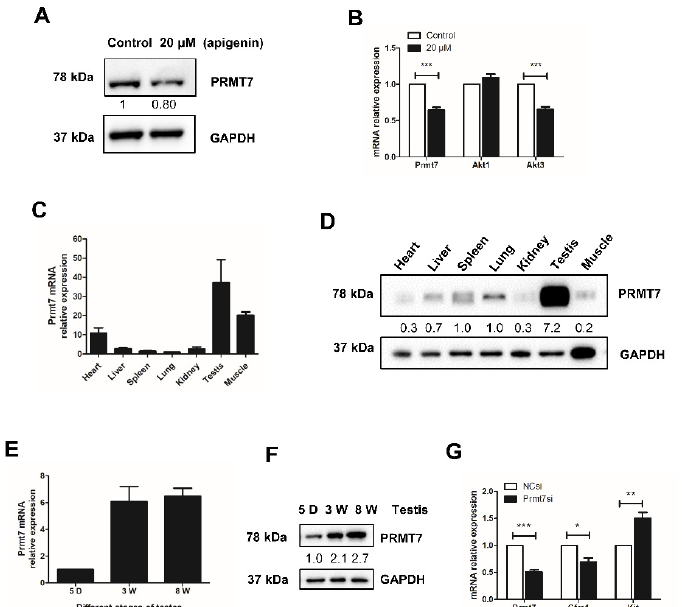
Figure 2. Effects of apigenin treatment on the expression of protein arginine methyltransferase 7 ( Prmt7 ) and Akt3 as well as Prmt7 expression profile in mouse tissues. ( A ) The protein level of PRMT7 was detected by Western blotting in spermatogonia treated with 0 and 20 µ M apigenin for 48 h. ( B ) Relative mRNA expression of Prmt7 , Akt1 , and Akt3 was examined by RT-qPCR in spermatogonia treated with 0 and 20 µ M apigenin for 48 h. ( C ) Relative mRNA expression of Prmt7 examined by RT-qPCR in the heart, liver, spleen, lung, kidney, testis, and muscle of 8-week old mice. ( D ) The protein level of PRMT7 was detected by Western blotting in the heart, liver, spleen, lung, kidney, testis, and muscle of 8-week old mice. ( E ) Relative mRNA expression of Prmt7 examined by RT-qPCR in the testes of 5-day (5 D), 3-week (3 W), and 8-week (8 W) old mice. ( F ) The protein level of PRMT7 was detected by Western blotting in the testes of 5 D, 3 W, and 8 W old mice. ( G ) Relative mRNA expression of Prmt7 , Gfra1 , and Kit examined by RT-qPCR in negative control siRNA (NCsi)- and Prmt7 siRNA (Prmt7si)-transfected spermatogonia for 48 h. Data from three independent experiments are expressed as mean ± SEM. * indicates statistical significance. * p < 0.05, ** p < 0.01, and *** p < 0.001.